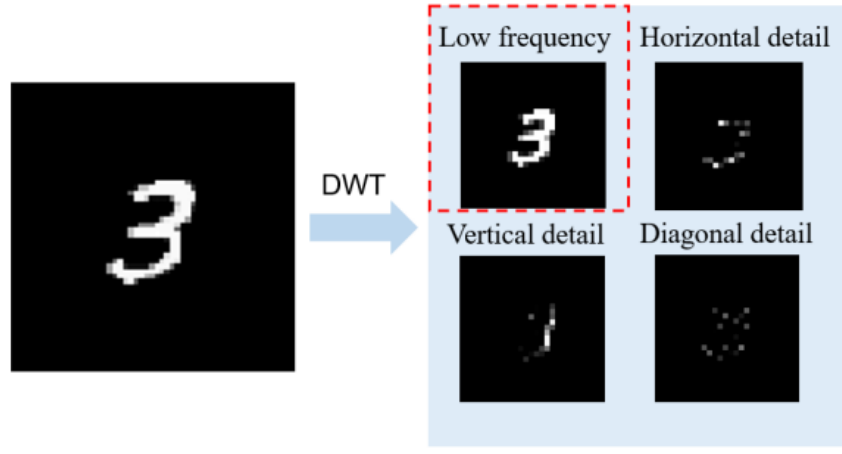
Figure 4. First order decomposition of DWT.